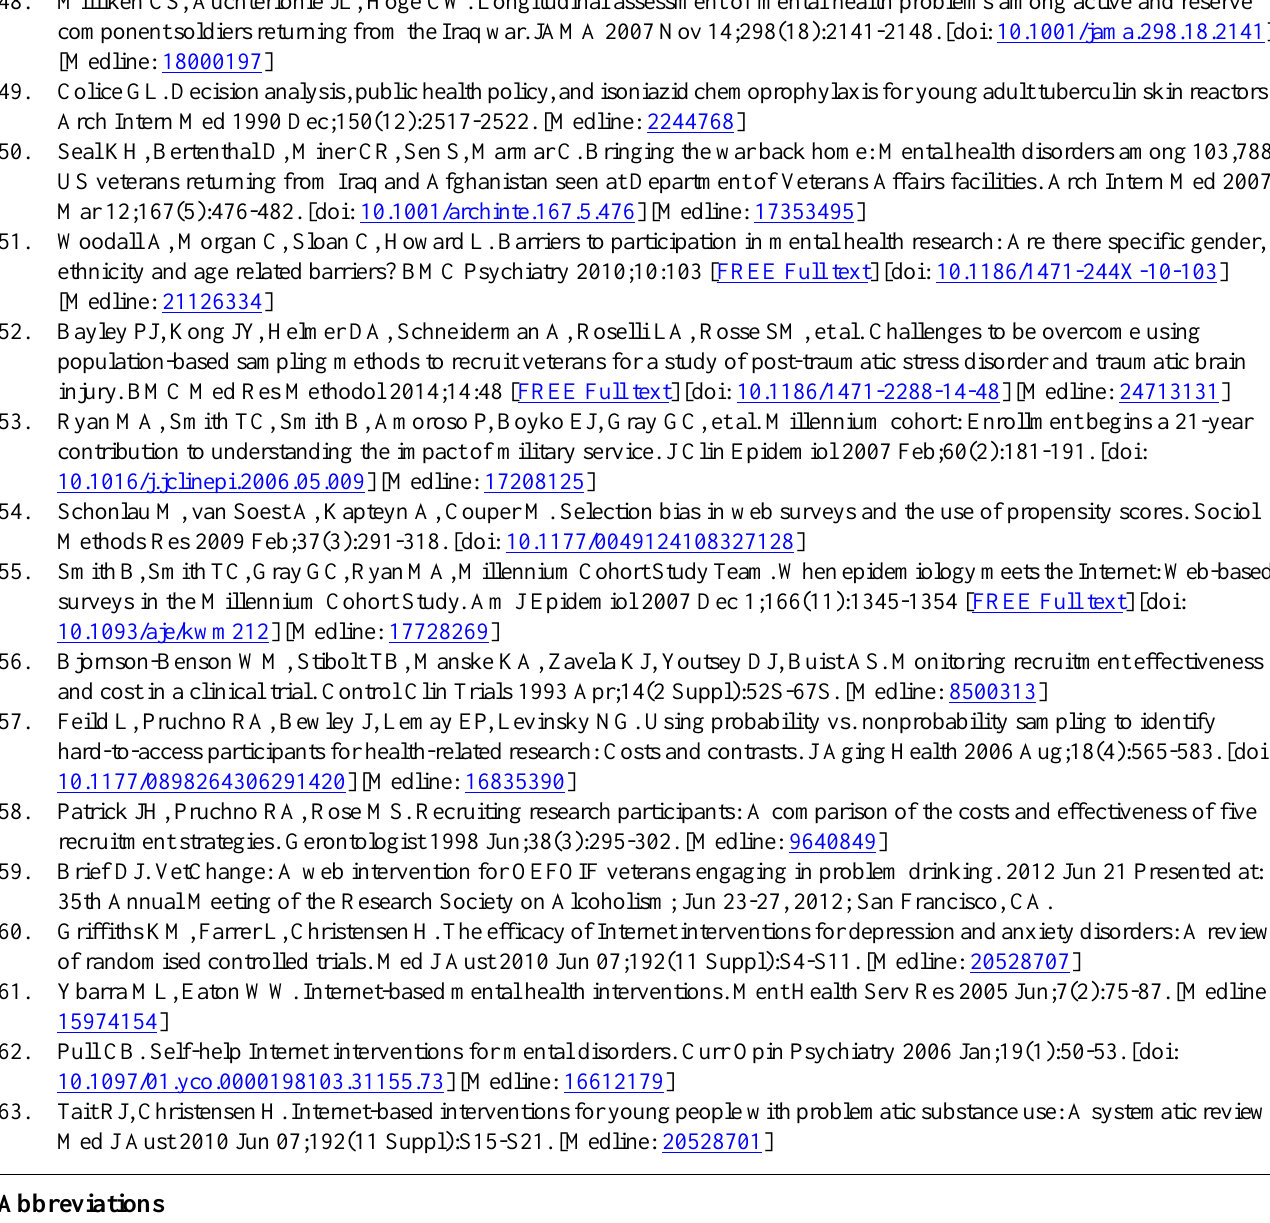
Abbreviations ACS: American Community Survey GAD: generalized anxiety disorder GAD-7: Generalized Anxiety Disorder-7 Item